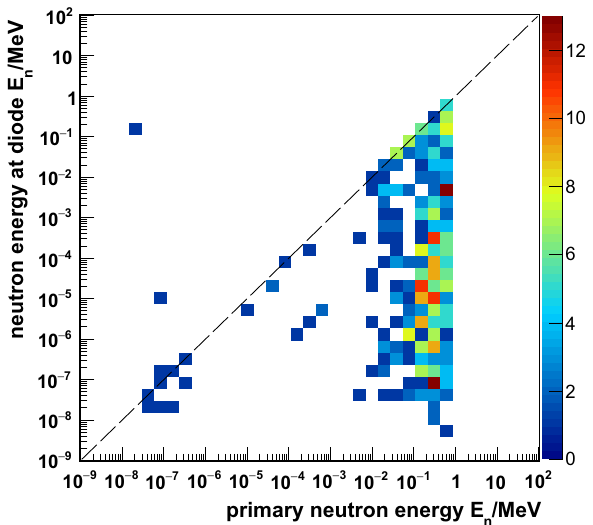
Fig. 25 Neutrons arriving at one CONUS HPGe diode plotted against the energy of the primary neutrons. Dashed line at 45 ◦ for orientation